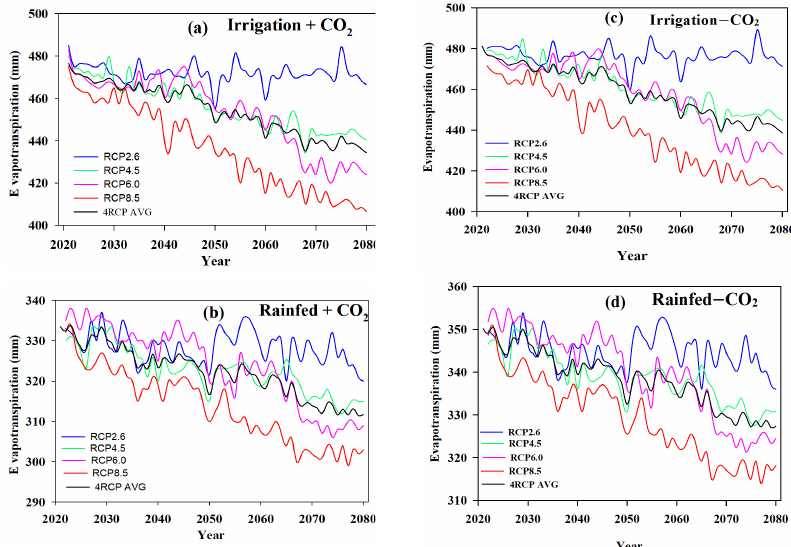
Figure 6. Temporal evolutions of the maize crop evapotranspiration with and without increased CO 2. ( a ) Irrigation + CO 2 ( b ) Rainfed + CO 2 ( c ) Irrigation − CO 2 ( d ) Rainfed − CO 2. The simulated irrigated and rainfed WUE with CO 2 fertilization in all scenarios varies, ranging from 15.0 to 12.0 kg ha − 1 mm − 1 , 15.0 to 11.5 kg ha − 1 mm − 1 , 14.9 to 10.6 kg ha − 1 mm − 1 , 14.1 to 7.6 kg ha − 1